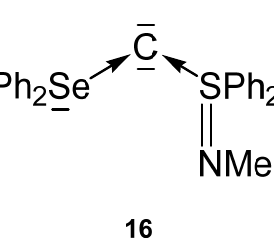
Figure 19. Carbone with Se and S based ligands L.